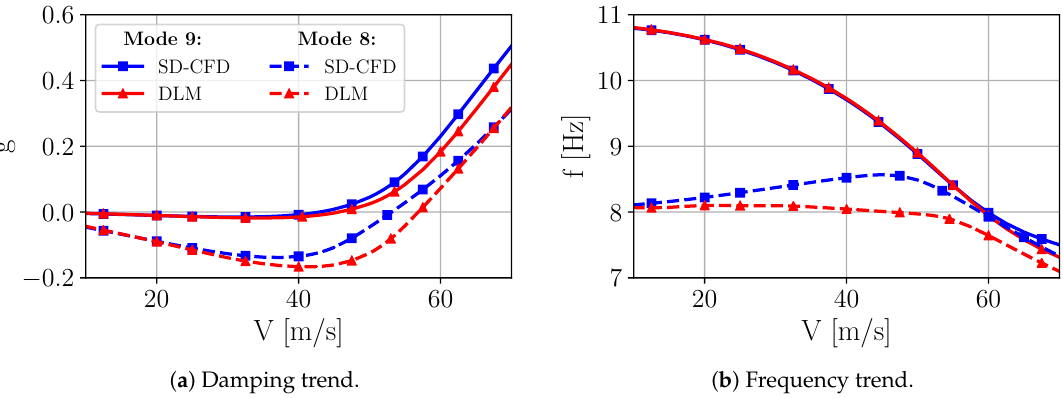
Figure 23. Comparison of SD-CFD and DLM modeling with regard to the resulting behaviour of the flutter